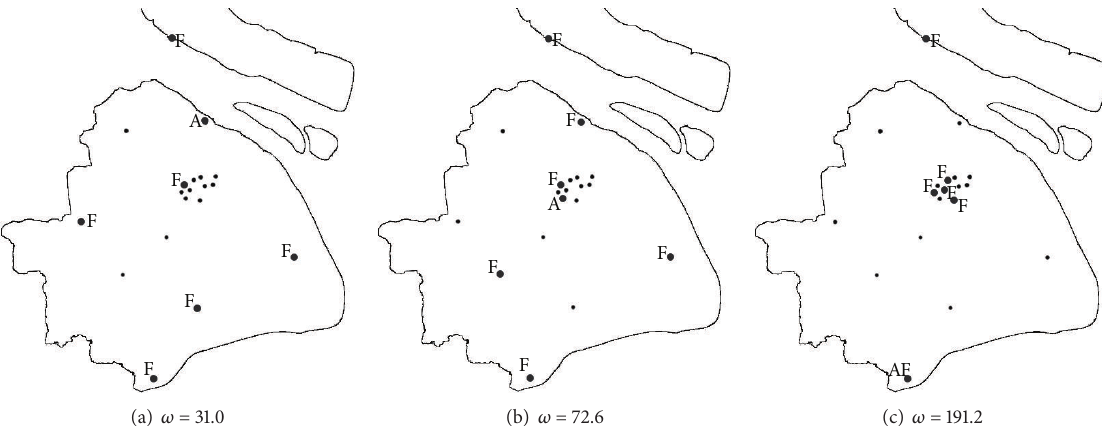
Figure 4: The facility location “F” and the district attacked “A” in equilibrium when 𝐶 = 200 , 𝑚 = 6